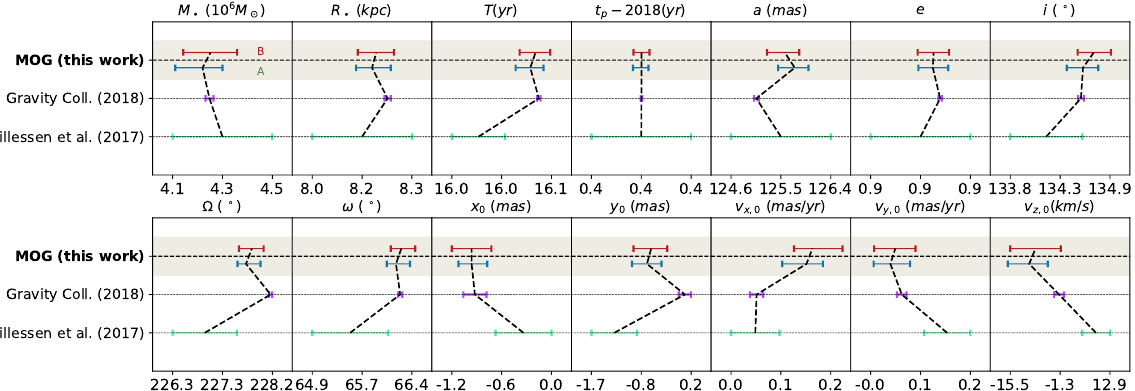
Figure 2. The best fitting values and 1 σ confidence interval for the orbital parameters of the S2 star in our analyses A (blue bars) and B (red bars), compared with the best-fitting values from previous works in [11] (in which 1-PPN model is fitted to the data) and [10] (using a Keplerian model to describe the orbit of